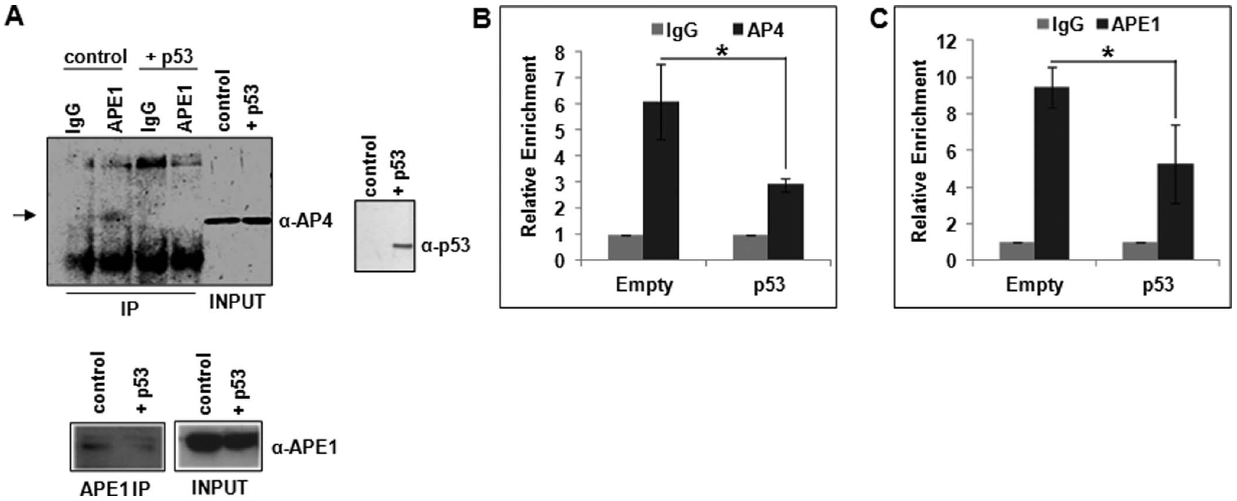
Figure 6. Effect of p53 in APE1/AP4 association and their recruitment to p21 promoter. ( A ) Western analysis of APE1-IP to detect APE1- associated AP4 in control vs. ectopic p53 expressing HCT116 p53null cells; AP4, APE1 and p53 levels also shown in input samples. ( B & C ) ChIP Real Time PCR analysis showing relative enrichment of ( B ) AP4 and ( C ) APE1 in p21 proximal promoter in control vs. ectopic p53-expressing HCT116 p53null cells; cells were transfected with empty vector or p53-expression vector and ChIP assay was performed after 48 hours; *: p value , 0.05 (n=5) calculated based on the relative enrichment of AP4 or APE1 in control vs. ectopic p53 expressing cells.